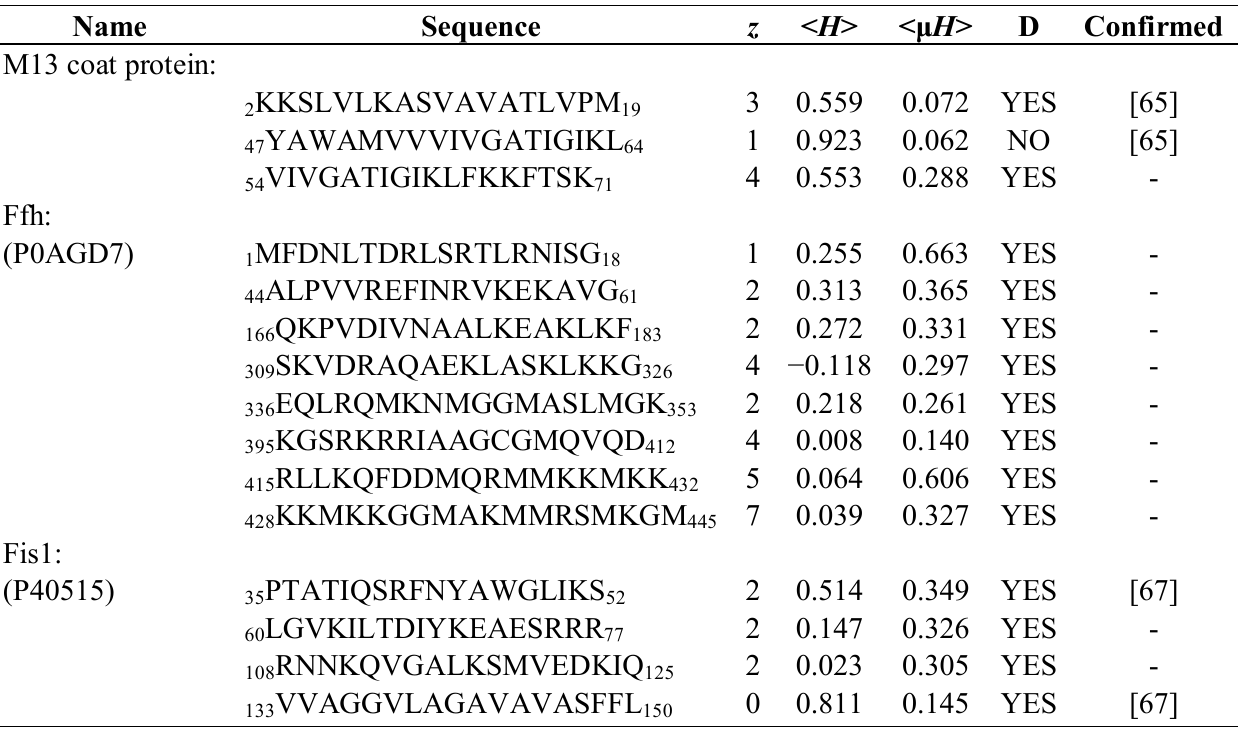
Table 3. Examples of the use of a combined Heliquest discrimination factor and a Heliquest generated Eisenberg plot methodology in the identification of potential lipid-binding